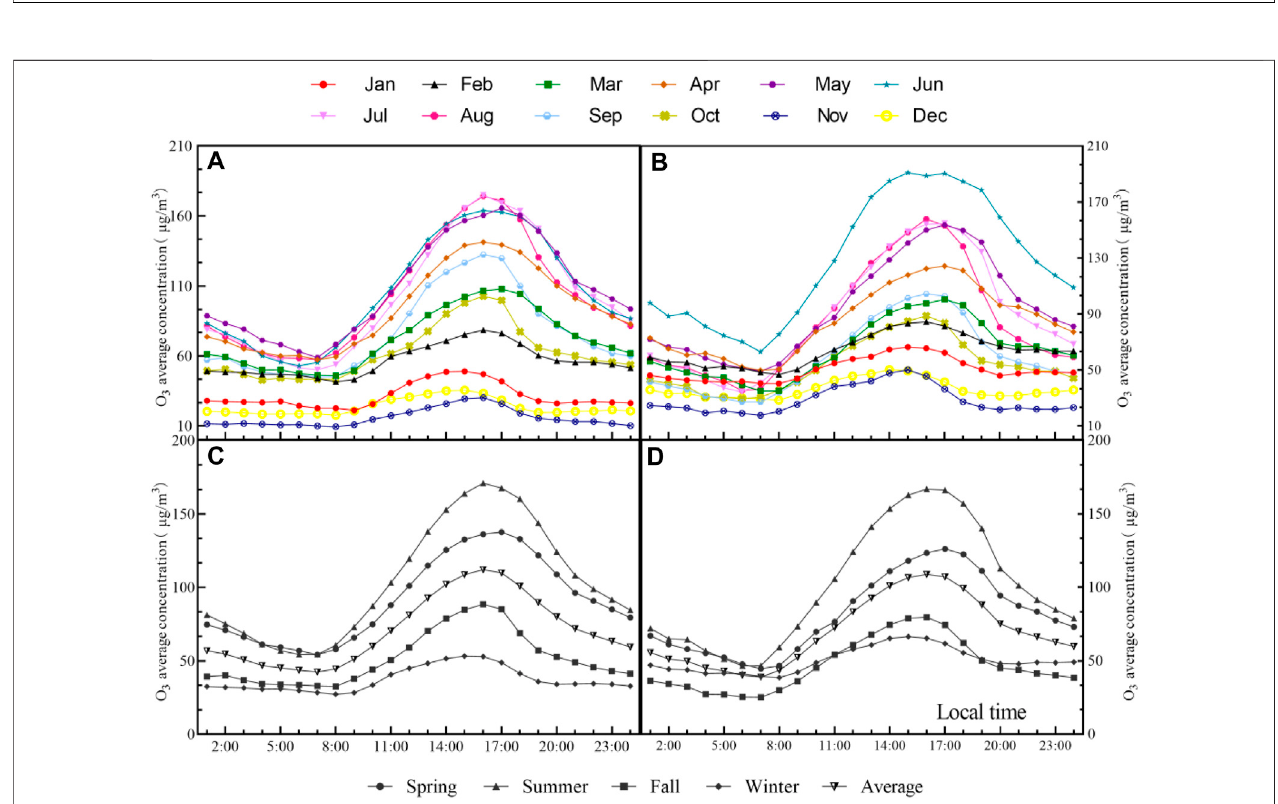
FIGURE 2 | Diurnal variation of O 3 concentrations at Dingling Station: diurnal variation in months (A, B) ; diurnal variation in seasons (C, D) in 2015.